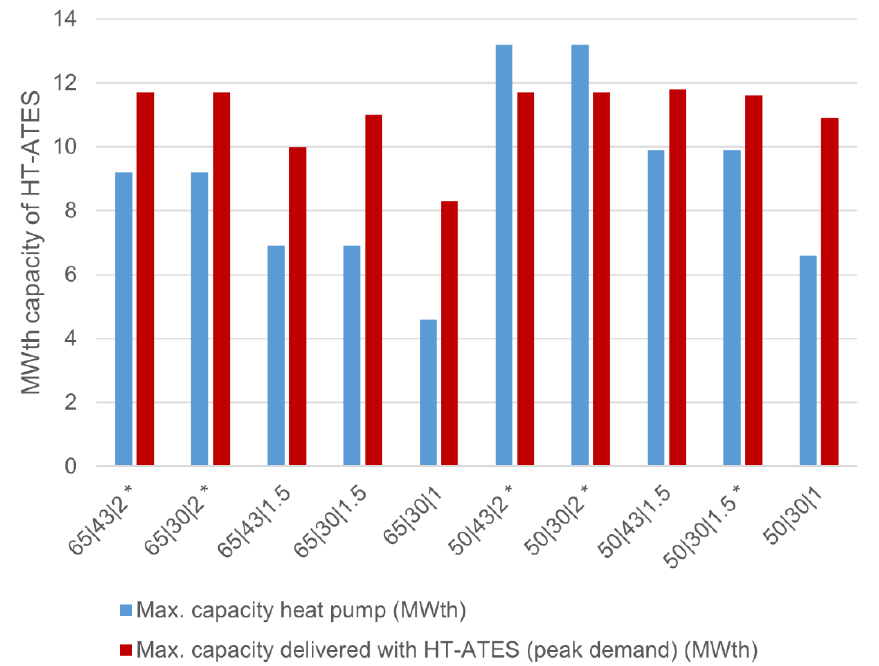
Figure 11. The maximum heat pump capacity vs. the heat delivery at the peak demand is shown for all scenarios. Because of the addition of the HT-ATES system, it is possible to deliver the peak demand from the HT-ATES, which explains why the maximum thermal heat pump capacity is lower than the maximum capacity delivered. The * sign shows which scenarios reach 100% heat delivery by the HT-ATES to the MES (within the first five years of operation).